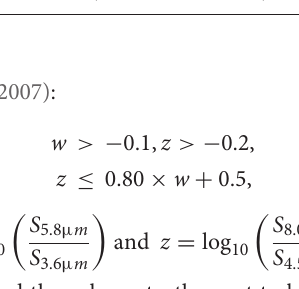
FIGURE 1 | Optical and mid-infrared colors for spectroscopic quasars in the Boötes field. The LOFAR detected quasars are plotted as redshift color-coded points according to the color bar at the lower right. The corresponding redshift bin is indicated by the colorbar legend. The dark green points represent spectroscopic quasars in the corresponding redshift that are undetected in our LOFAR observations, while the blue circles mark the location of stars. The solid magenta lines delimit the regions used to select the quasars in each color space. The gray contours denotes the density for 18,000 simulated quasars in the respective redshift